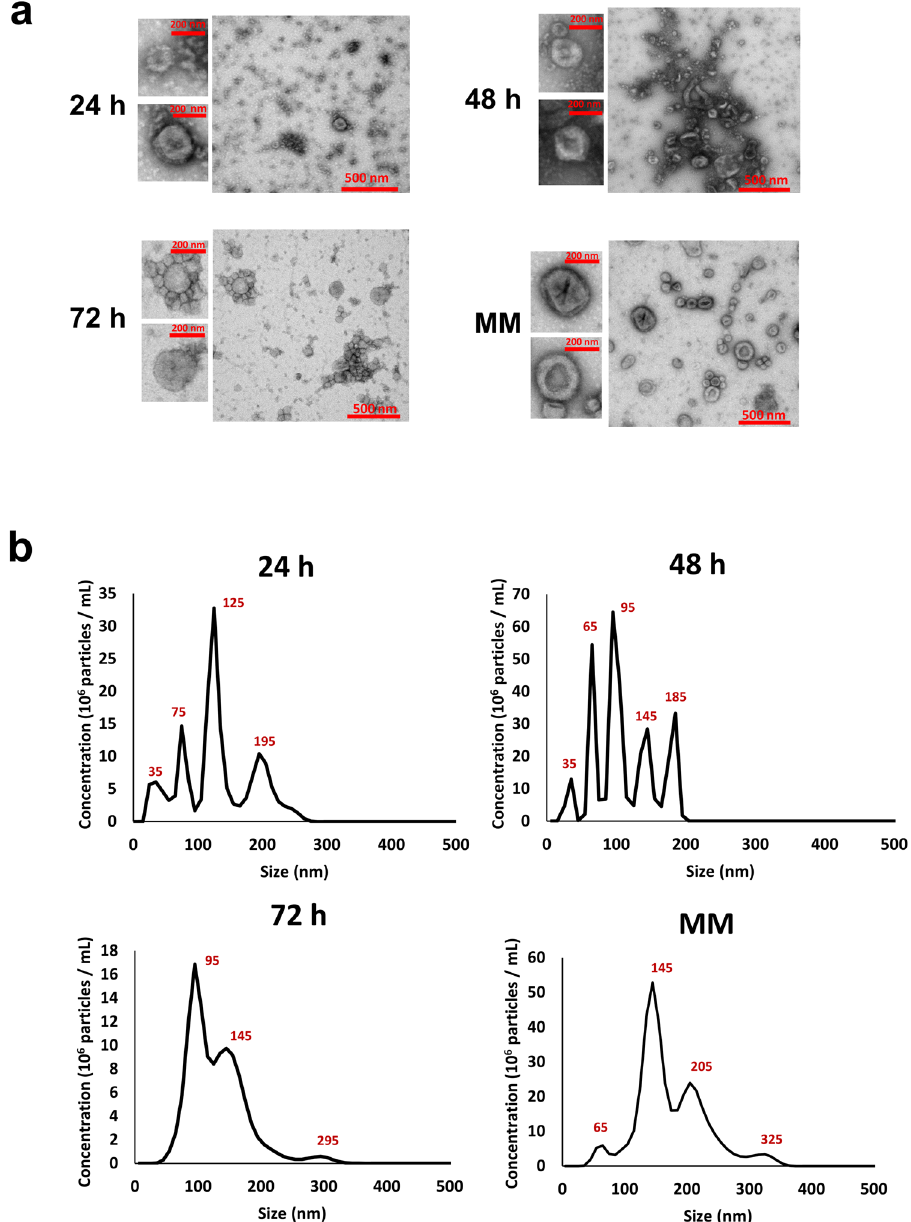
Figure 2. Biophysical characterization of exosomes isolated from MM and colostrum. ( a ) TEM images of exosomes isolated by OptiPrep density gradient centrifugation revealed vesicles with a morphology similar to exosomes and a diameter in the range of 30–150 nm for all four samples. The colostrum samples had meagrely scattered vesicles with higher protein background whereas the MM samples revealed a rich population of exosomes with typical cup-shaped morphology. ( b ) NTA revealed peak intensities to be 125, 95, 95 and 145 nm for 24, 48, 72 h colostrum and MM samples,